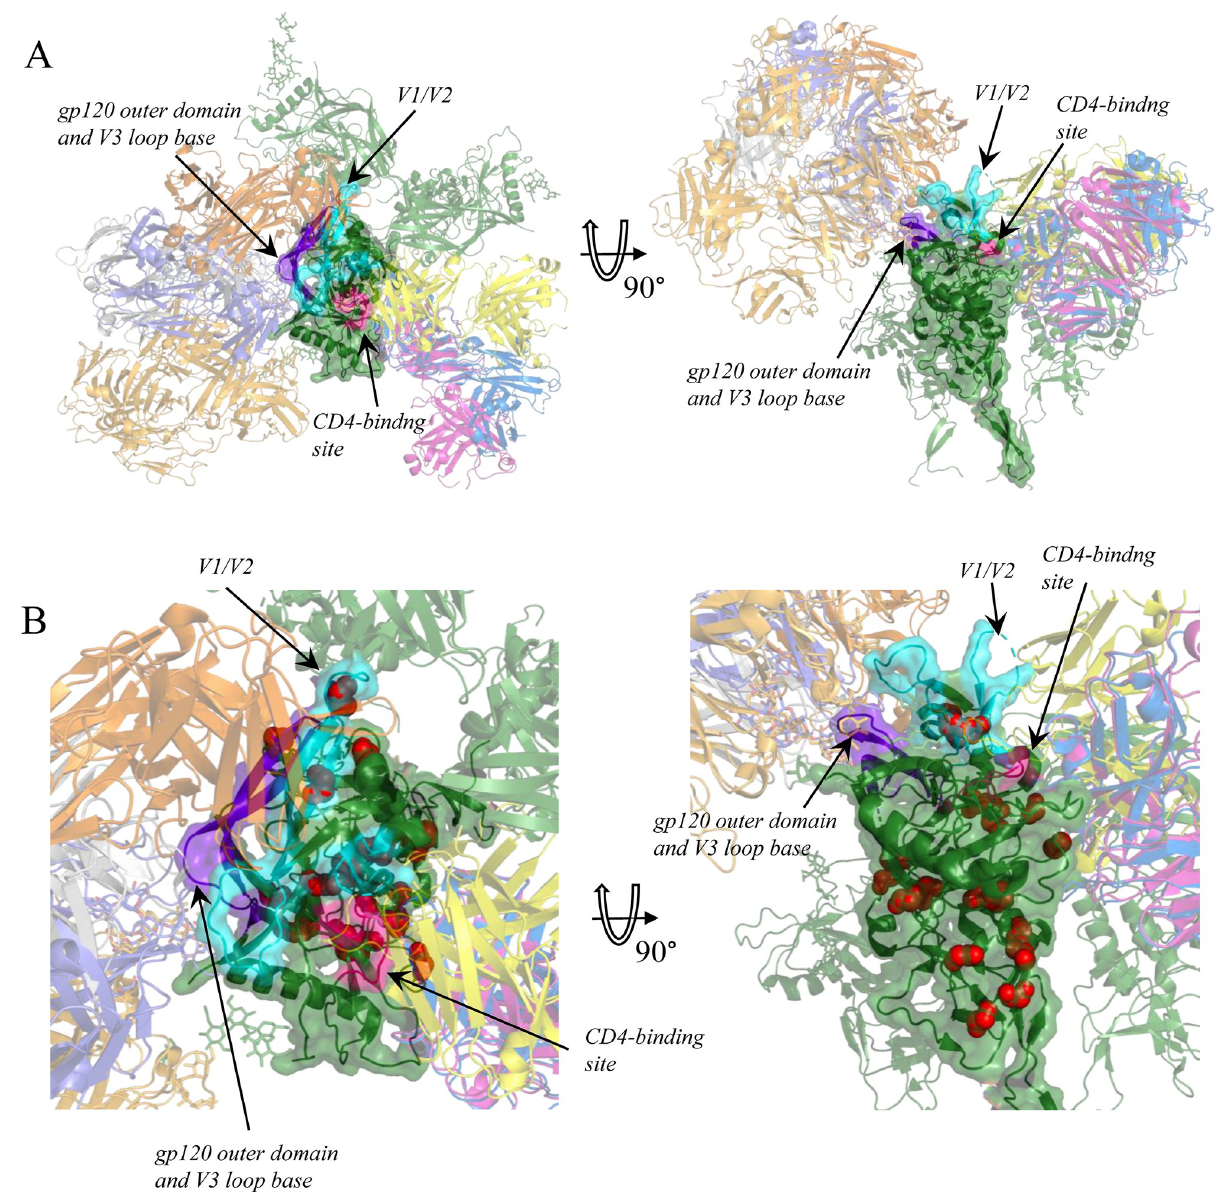
Fig 6. A , Overview of the structure of the gp120 trimer and its complexes with bnAbs (see Materials and methods). gp120 is colored green and shown as cartoons, one subunit is also shown as a semi-translucent surface. bnAbs are in various color and shown as cartoons. Glycan molecules are shown as sticks. bnAbs binding only one gp120 subunit are shown for clarity. B , Close-up of one gp120 subunit, with epitopes signed; sites with variable fitness amino acids between subtypes A and B shown as red spheres. Epitopic sites are defined according to [37]; CD4-binding site is colored pink, V1/V2 loop region cyan, and V3 loop region